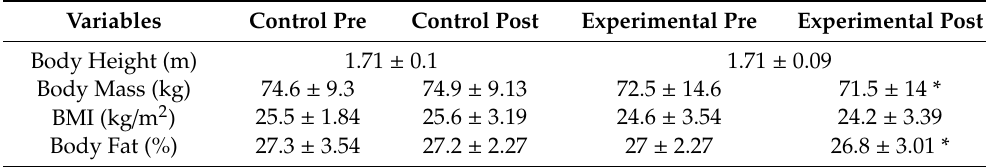
Table 3. Changes in participants’ body